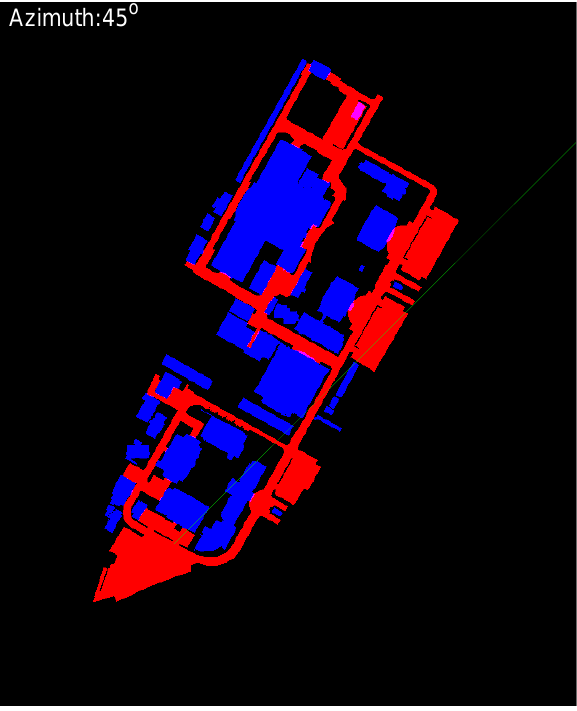
Figure 3. Example of EM calculation